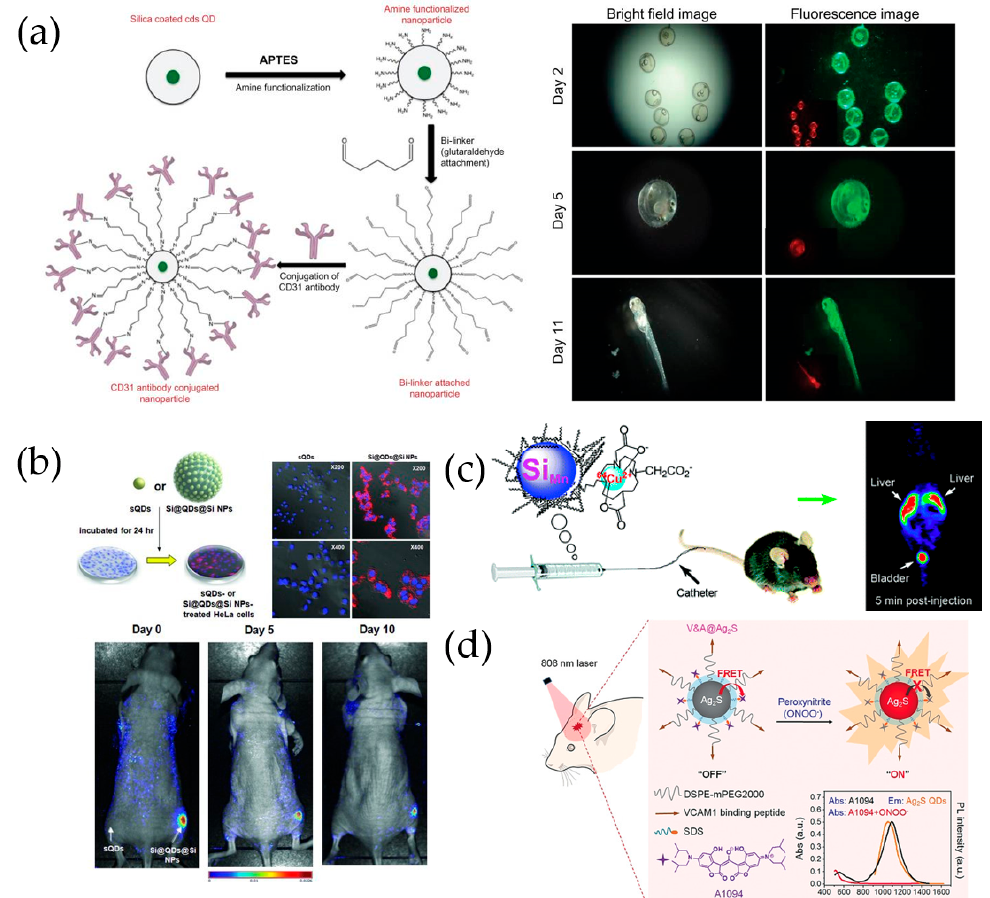
Figure 6. ( a ) Antibody conjugation onto silica-coated CdS QDs and in vivo fluorescence imaging of silica-coated CdS QD-treated embryos [75]. ( b ) In vivo cellular uptake of sQDs and SiO 2 @QDs@ SiO 2 NPs [37]. ( c ) Use of dextran-coated silicon QDs in PET imaging and biodistribution [77]. Reprinted with permission from ACS Med. Chem. Lett. 2011, 2, 4, 285–288. Copyright 2011 American Chemical Society. ( d ) V&A@Ag 2 S probe preparation and in vivo detection of peroxynitrite